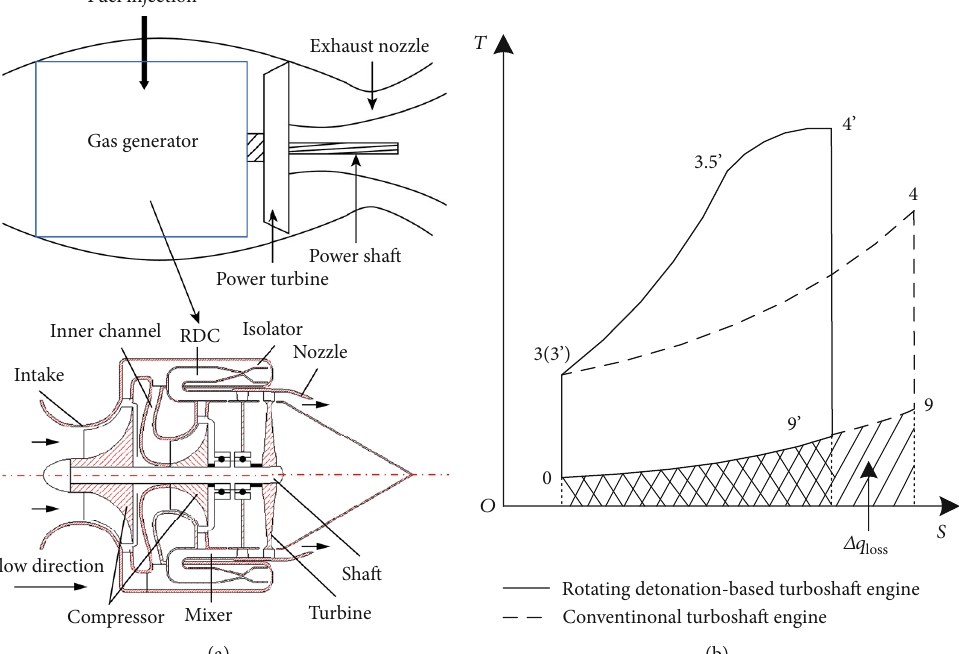
Figure 2: (a) Con fi guration and (b) ideal thermodynamic cycle processes of the rotating detonation-based turboshaft